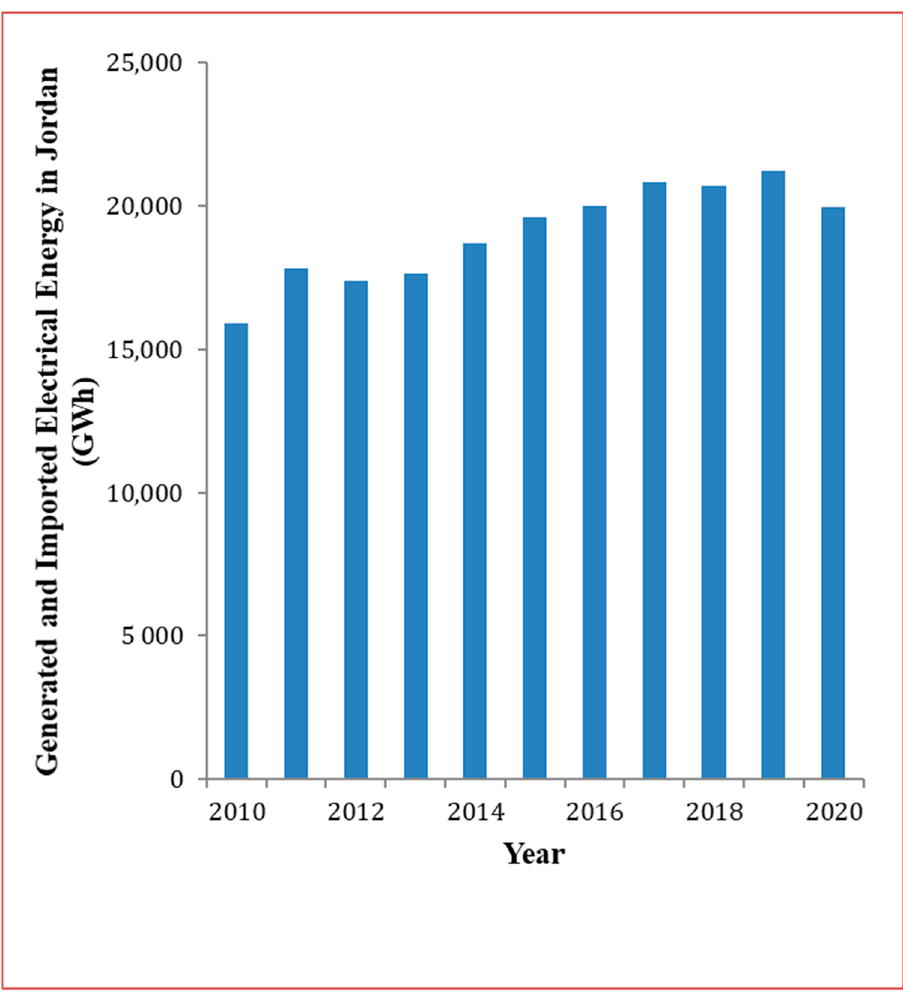
Figure 21. Generated and imported electrical energy 2010–2020.